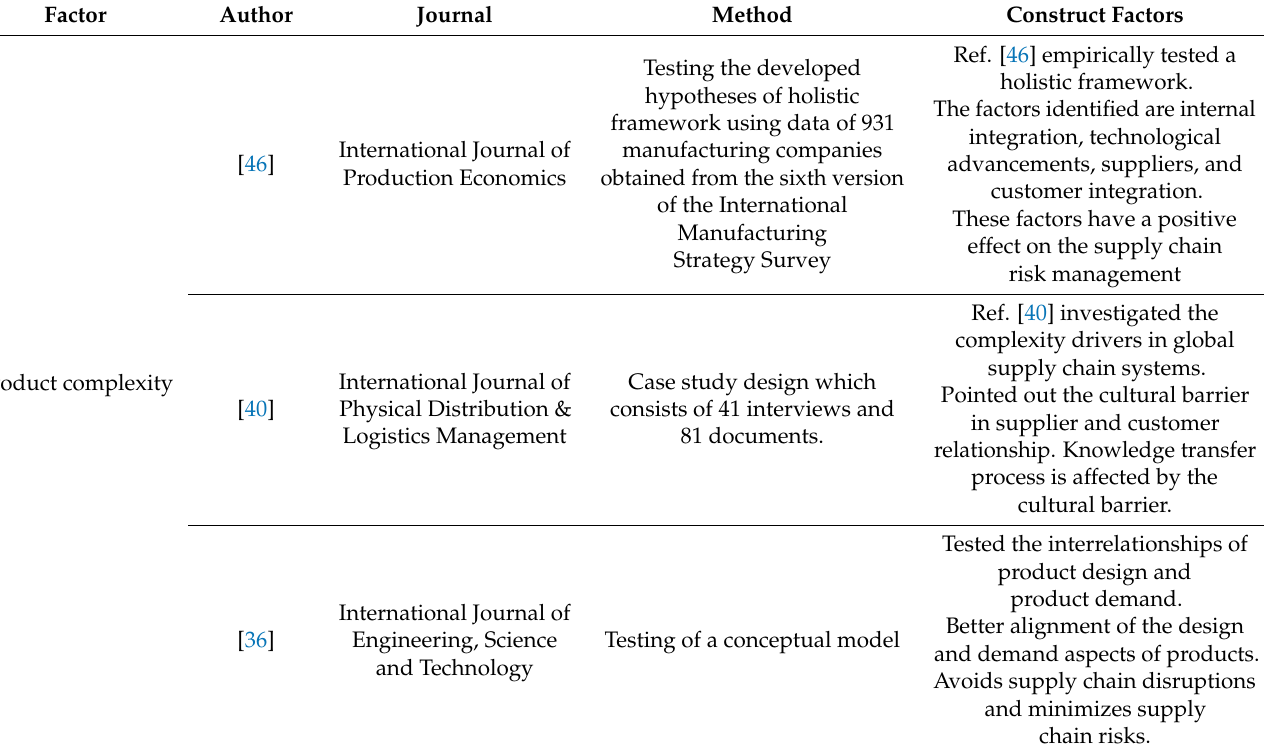
Table 3. Construct Factors gathered for product complexity (author’s